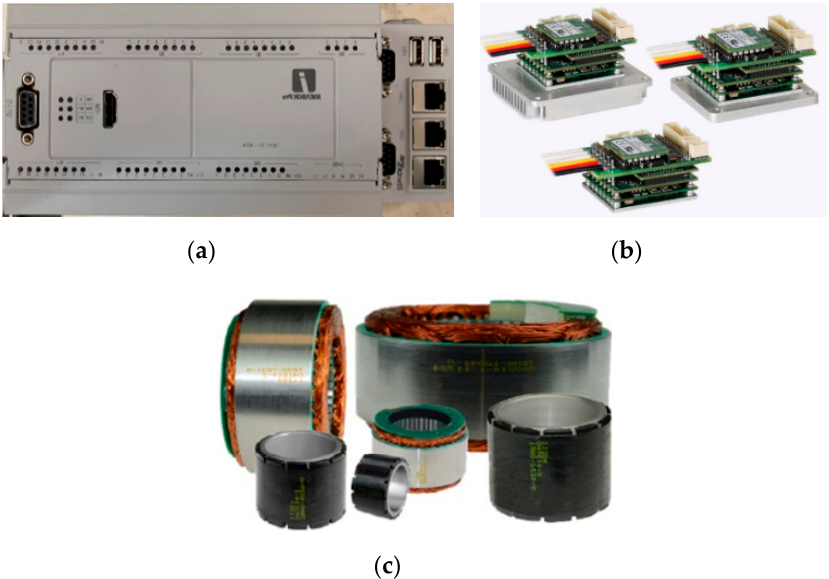
Figure 8. Some key parts of the proposed collaborative robot, ( a )–( c ) are the main controller, motor driver and frameless motor of the robot.